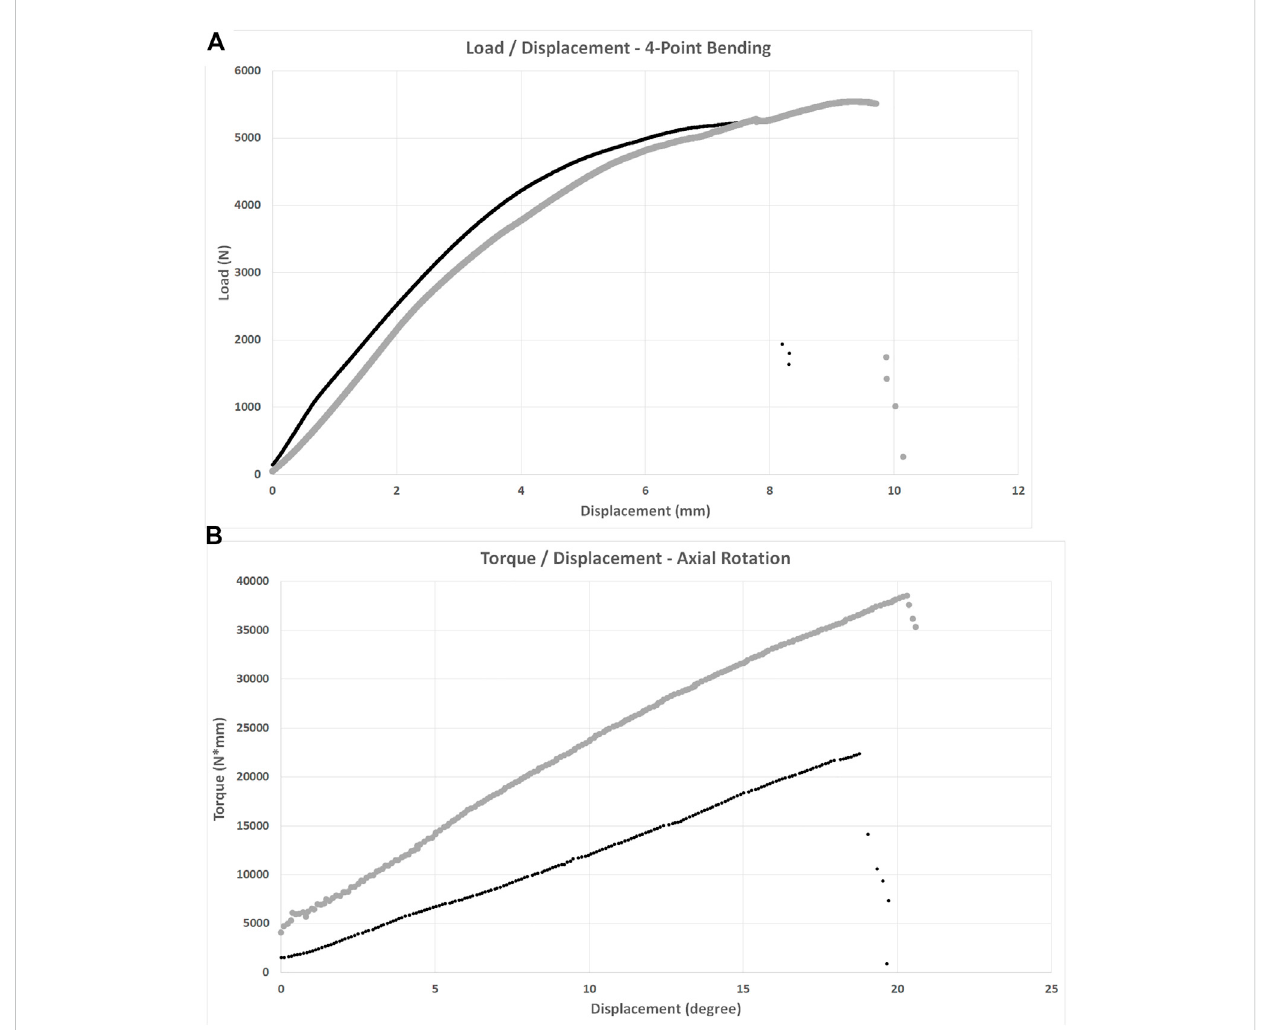
FIGURE 4 Load/displacement curves for 4-point bending (A) and axial torsion (B) BFX + lb implanted femurs are indicated using black markers and CFX implanted femurs are indicated using grey markers. For axial torsion testing, the degrees at ultimate failure was corrected to account for an initial toe regionofthedatathatimpliedadelayinthe fi xturecontactingtheneckoftheimplant.Forbothtests,stiffnesswascalculatedfromtheinitiallinearportion of each curve and ultimate failure was de fi ned as the point at which load acutely decreased. CFX implanted femurs were stiffer than BFX + lb implanted femurs when subjected to axial